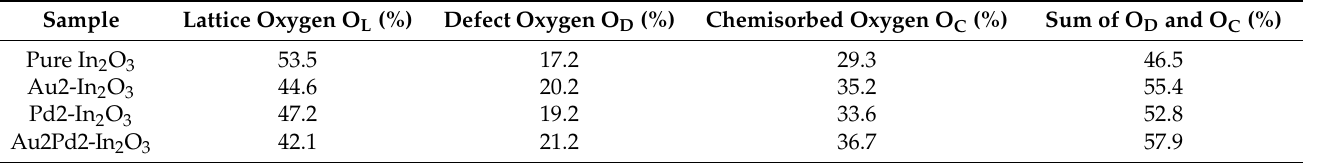
Figure 5. ( a ) XPS survey scan; high-resolution XPS spectra of ( b ) In 3d of pure and Au2Pd2-In 2 O 3 ; ( c ) Au 4f Pd 3d of ( d ) pure and ( e ) Au2Pd2-In 2 O 3 ; ( f – i ) O 1s XPS spectra of pure, Au2-In 2 O 3 , Pd2-In 2 O 3 , Au2Pd2-In 2 O 3 . Table 2. Percentages of three different O 1s components in the four samples.